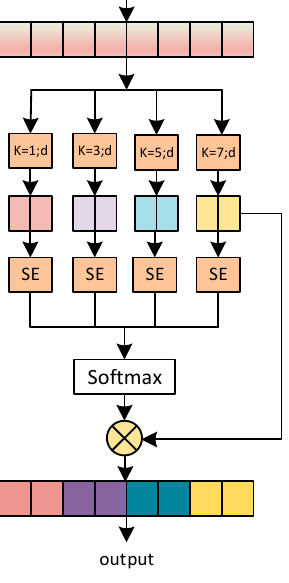
Figure 2. Structure of MSCA.